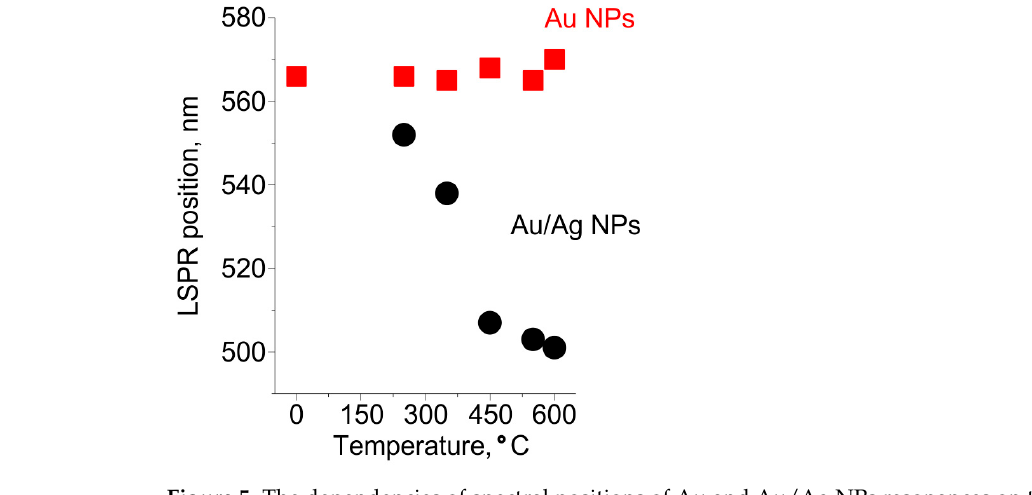
Figure 5. The dependencies of spectral positions of Au and Au/Ag NPs resonances on the temperature of heat treatment.